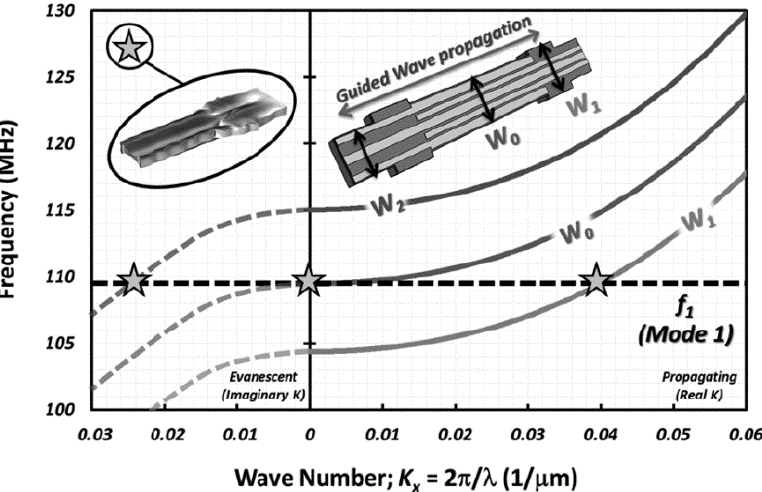
Figure 15. Dispersive behavior of propagating waves. Reproduced with permission from [109]. Copyright © 2013, IEEE.